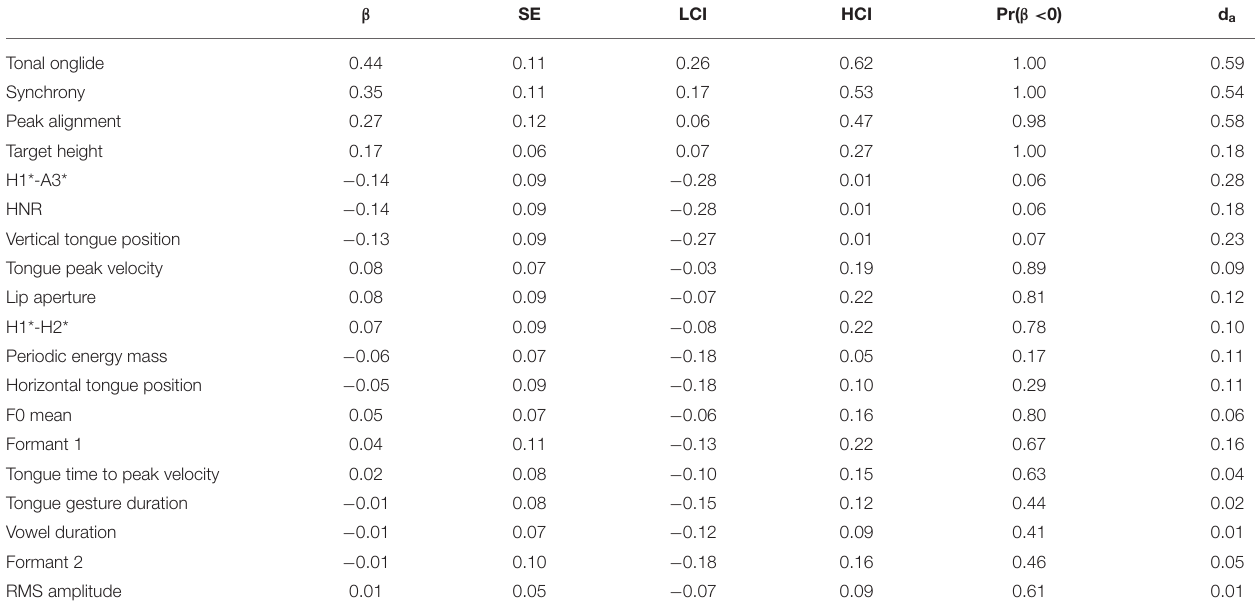
TABLE 10 | Tabular overview of modeling results for narrow vs. contrastive focus, vowel /o/. LCI and HCI refer to the low and high boundaries of the 90% Credible